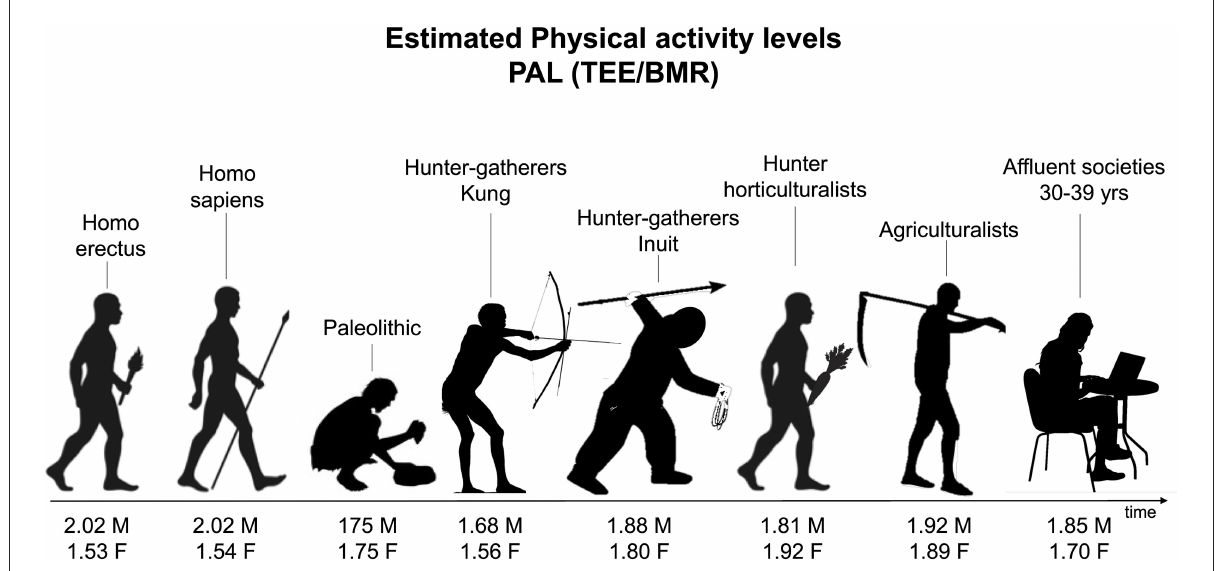
FIGURE1 Estimated physical activity levels (PALs) for ancestors and modern populations. PAL = TEE/BMR (total energy expenditure/basal metabolic rate), see for details, Malina and Little (17).